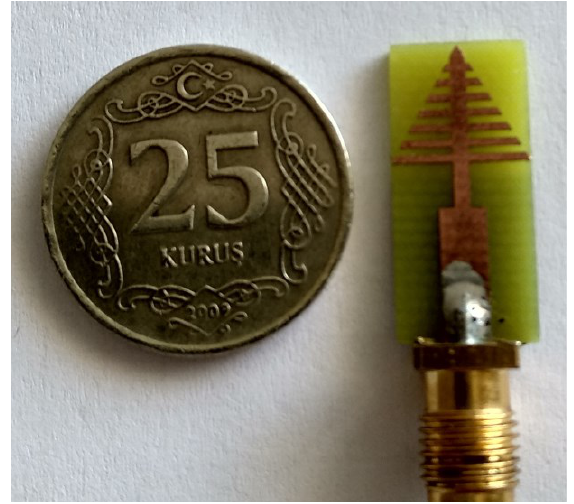
Figure 2: Photograph of the